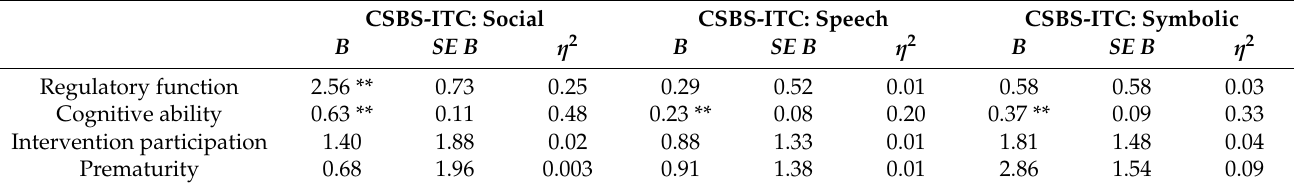
Table 5. Multivariate multiple regression results predicting CSBS-ITC